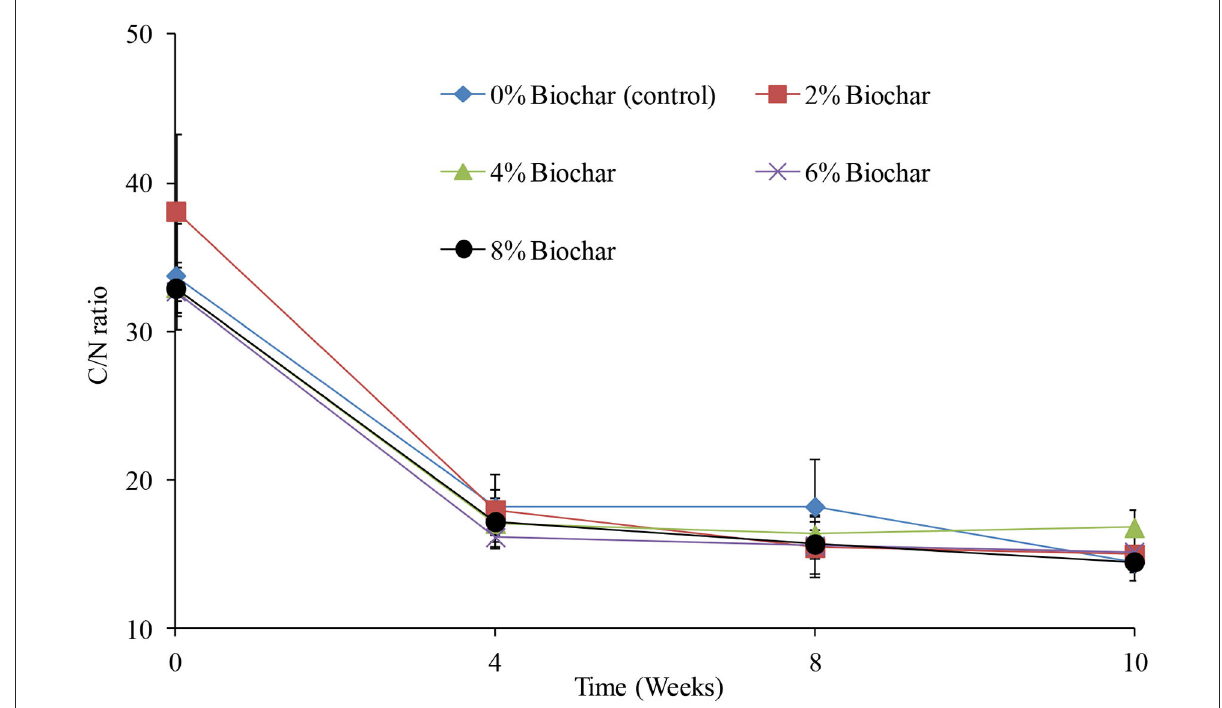
FIGURE3 Changes in carbon-to-nitrogen ratio (C/N) during vermicomposting of a goat manure–food waste mixture amended with seaweed ( G. funicularis ) biochar into. Error bars indicate standard